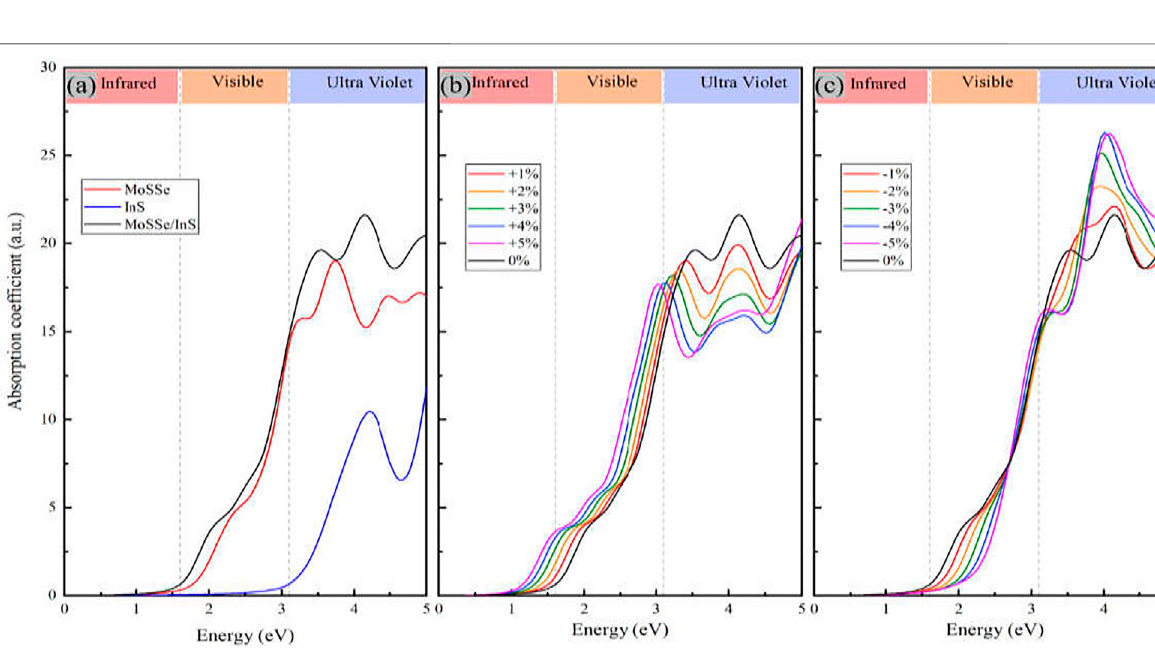
Frontiers in Chemistry |